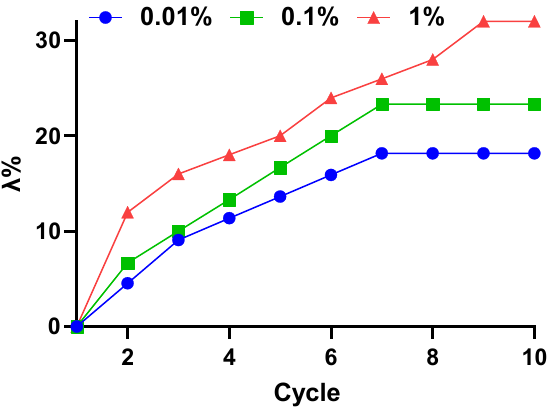
Figure 6. Dependence of the parameter λ on the number of cycles loading. Significant changes could be seen within the first cycle and only moderate changes (3%) for the following cycles. A linear increase in parameter λ could also be observed with the corresponding rates of its growth per cycle, which was approximately 3% from the second cycle up to the saturation point (7th cycle). The hysteresis nature of the MRE was more prevalent under shear strain of 1%, with parameter λ measuring a larger value than its counterpart (about 8% higher than 0.1% strain and 14% higher than 0.01% strain). Fur ‐ thermore, at 1% shear strain, the parameter λ continued to grow after the 7th cycle and saturated much later at the 9th cycle. The high magnitude of λ indicated that the displace ‐ ment of interfacial slipping between the CIP and the matrix was large enough to warrant